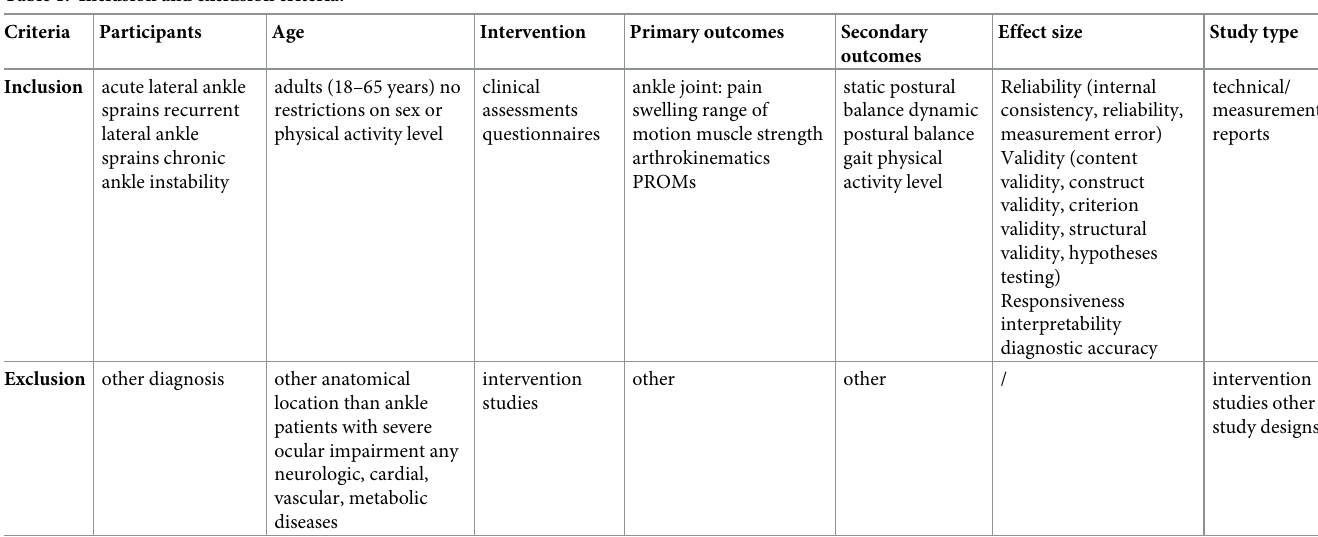
Table 1. Inclusion and exclusion